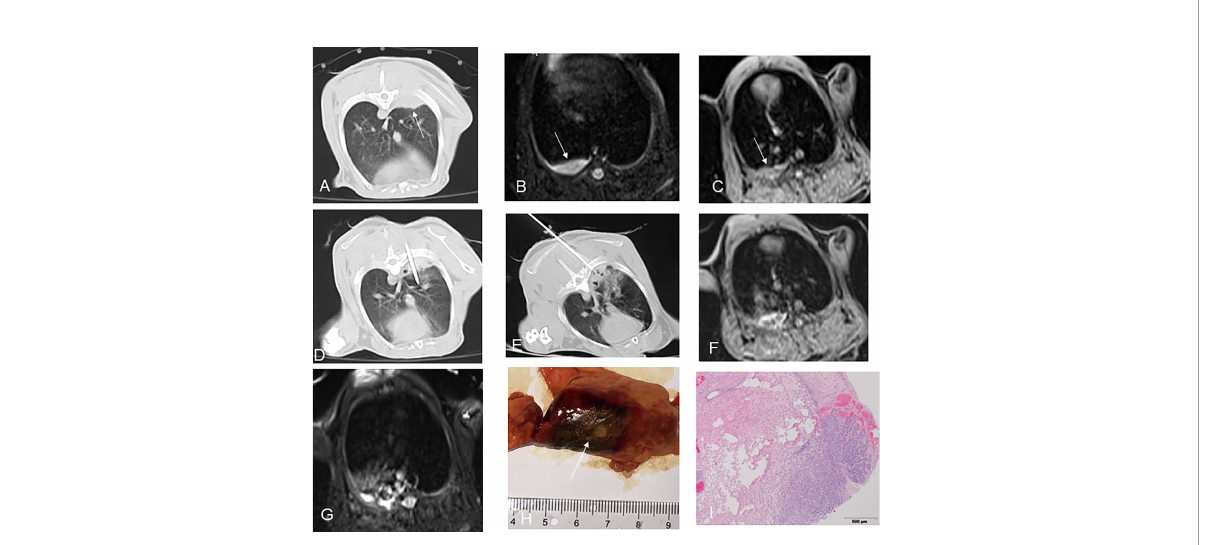
FIGURE 3 CT-guided MWA for rabbit lung VX2 tumor with MR and pathological fi ndings. CT showed a VX2 tumor located in right lower lobe with 13 mm in diameter and invasion of adjacent pleura ( A , arrow). The pre-ablation MR scan of the tumor showed hyperintensity on T2WI and isointense zone on T1WI before MWA ( B, C , arrow). MW antenna was gradually punctured into the tumor under CT guidance (D) . GGO surrounding the lesion was displayed immediately after MWA on CT (E) . Immediately after MWA, MR showed short T1 and short T2 signals in the central area with patchy iso-T1 and long T2 signals in the periphery including adjacent pleura and chest wall (F, G) . Pathology showed coagulative necrosis of the ablation area including invasion of adjacent pleura, with peripheral hemorrhage and in fl ammatory reaction zone ( H, I arrow). MWA,